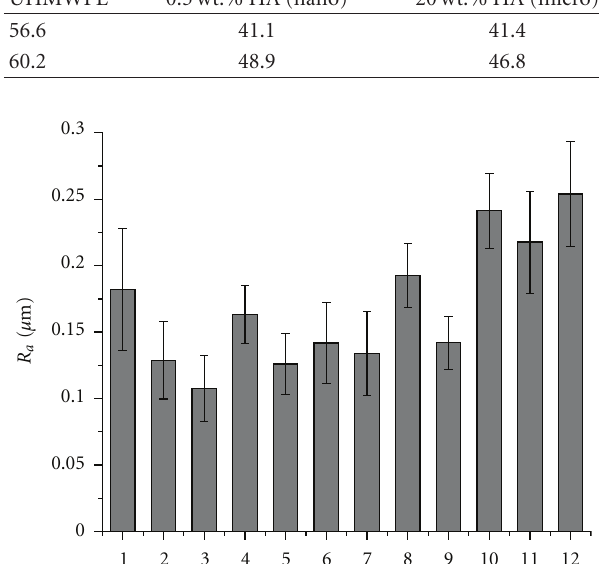
Figure 5: Dependence of surface roughness of wear track (Ra) of specimens under tests: pure UHMWPE (1), N + implanted UHMWPE with dozes: 0.5 (2), 1 (3), 2 · 10 17 (4); nanocomposites: UHMWPE +0.5wt.% HA without surface treatment (5) and implanted with dozes 0.5 (6), 1 (7), 2 · 10 17 N + (8); microcompos- ites: UHMWPE +20wt.% HA without ion implantation (9) and implanted with dozes 0.5 (10), 1 (11), 2 · 10 17 N + (12) at the steady- state wearing